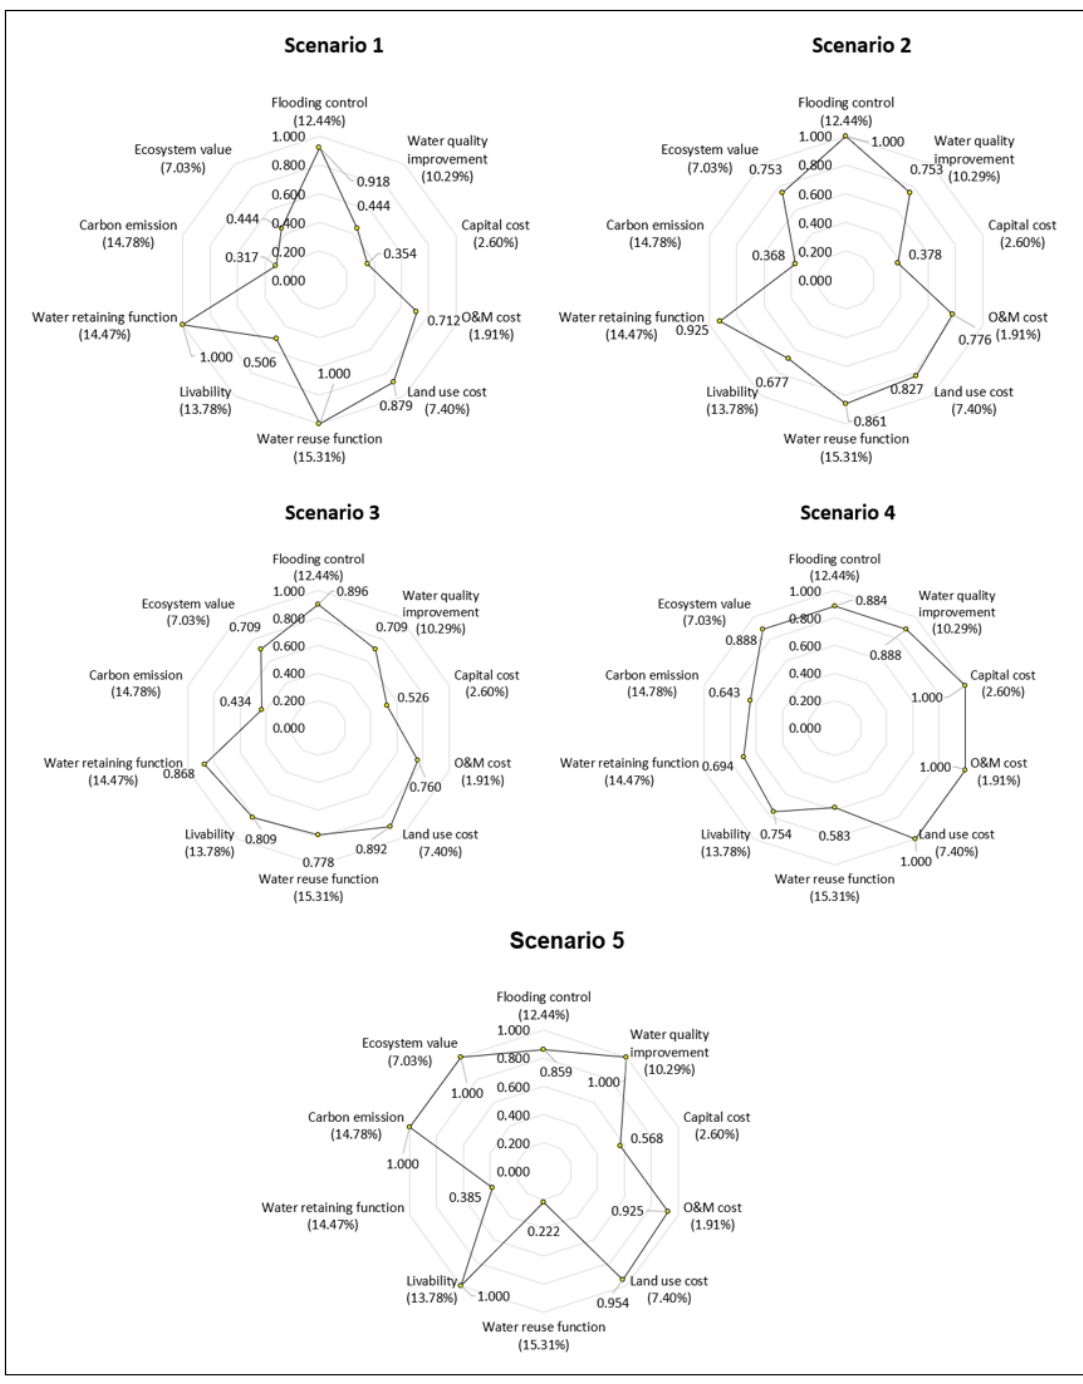
Figure 9. The spider diagrams of normalized results and weights.